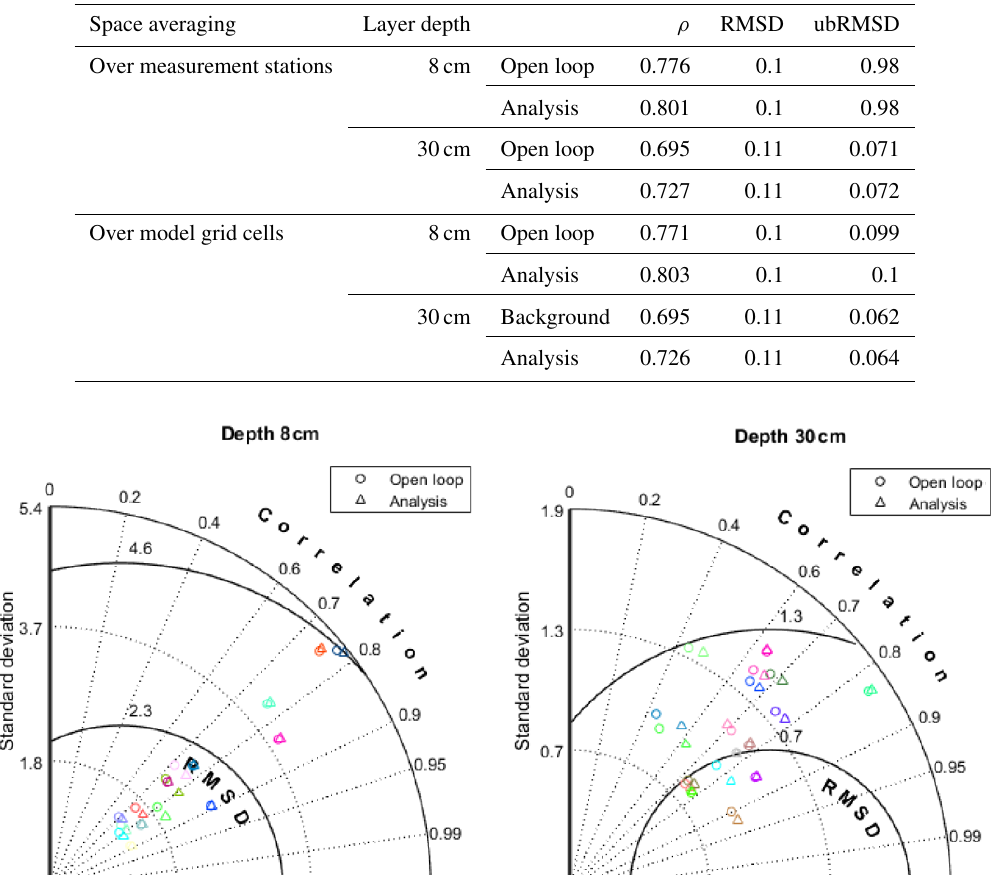
Table 4. Time–space average values of background and analysis performance (comparison with in situ observed soil moisture).